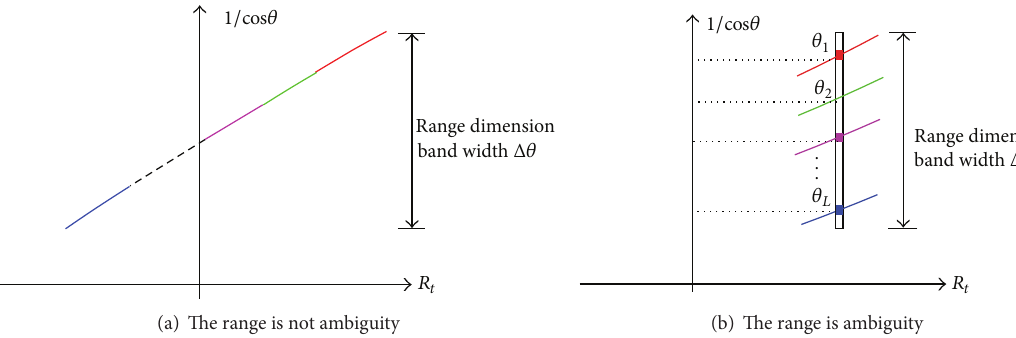
Figure 3: The relationship between downlooking angle and instantaneous slant